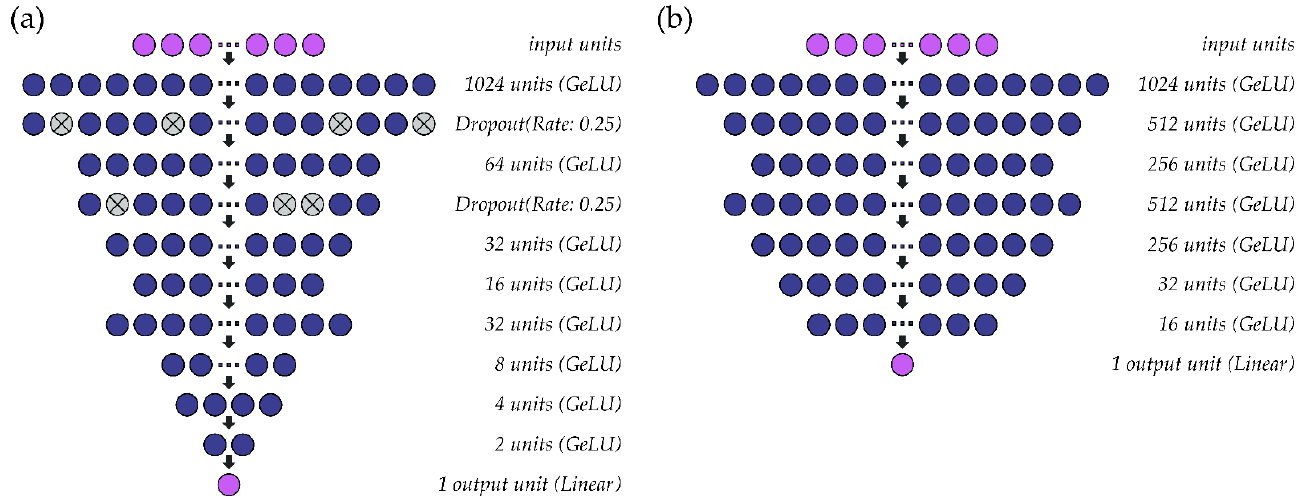
Figure 3. Structure of the multi-speaker deep regression neural networks used to estimate ( a ) f o and ( b ) intensity from sEMG signals.